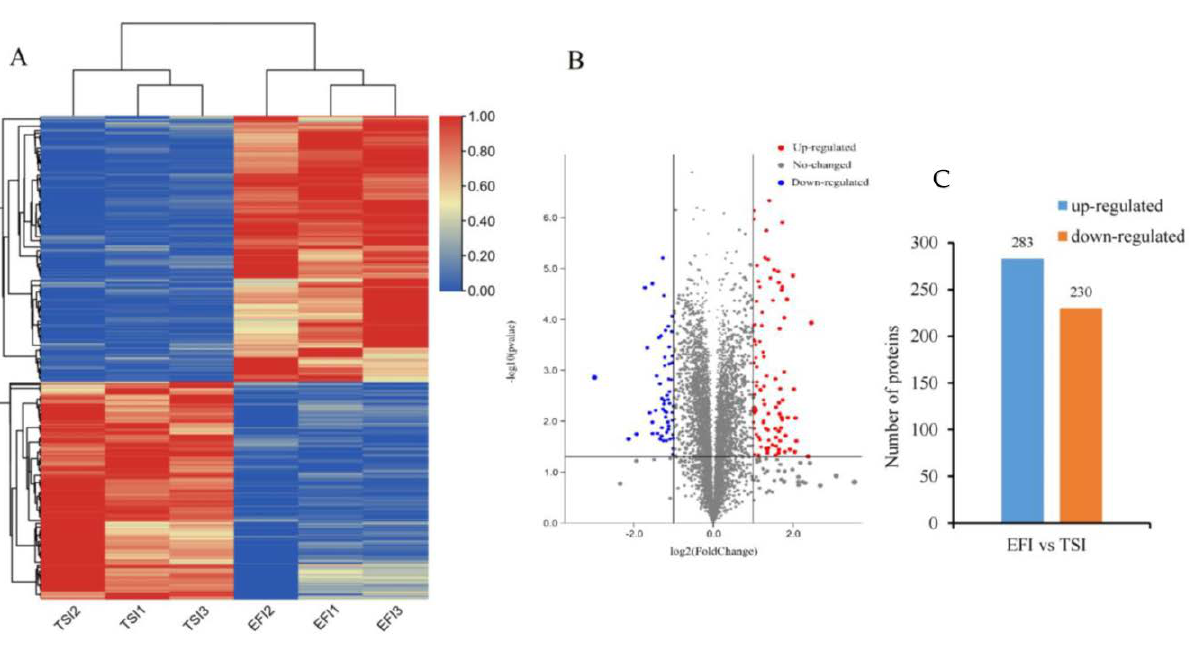
Figure 6. Effect of ebb-and-flow subirrigation strategy on proteome expressions of DAPs in tomato roots. ( A ) Expression profiles of the DAPs response to ebb-and-flow subirrigation. ( B ) Volcano plot of DAPs. ( C ) The numbers of up- and down-regulated proteins in the EFI treated plants compared to the